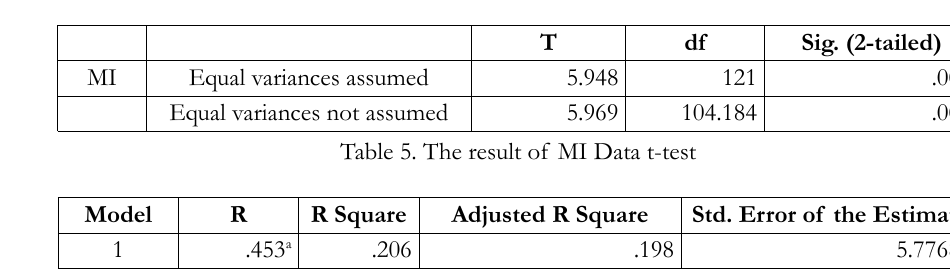
Table 4. MI Gain Score of Control and Experimental Groups